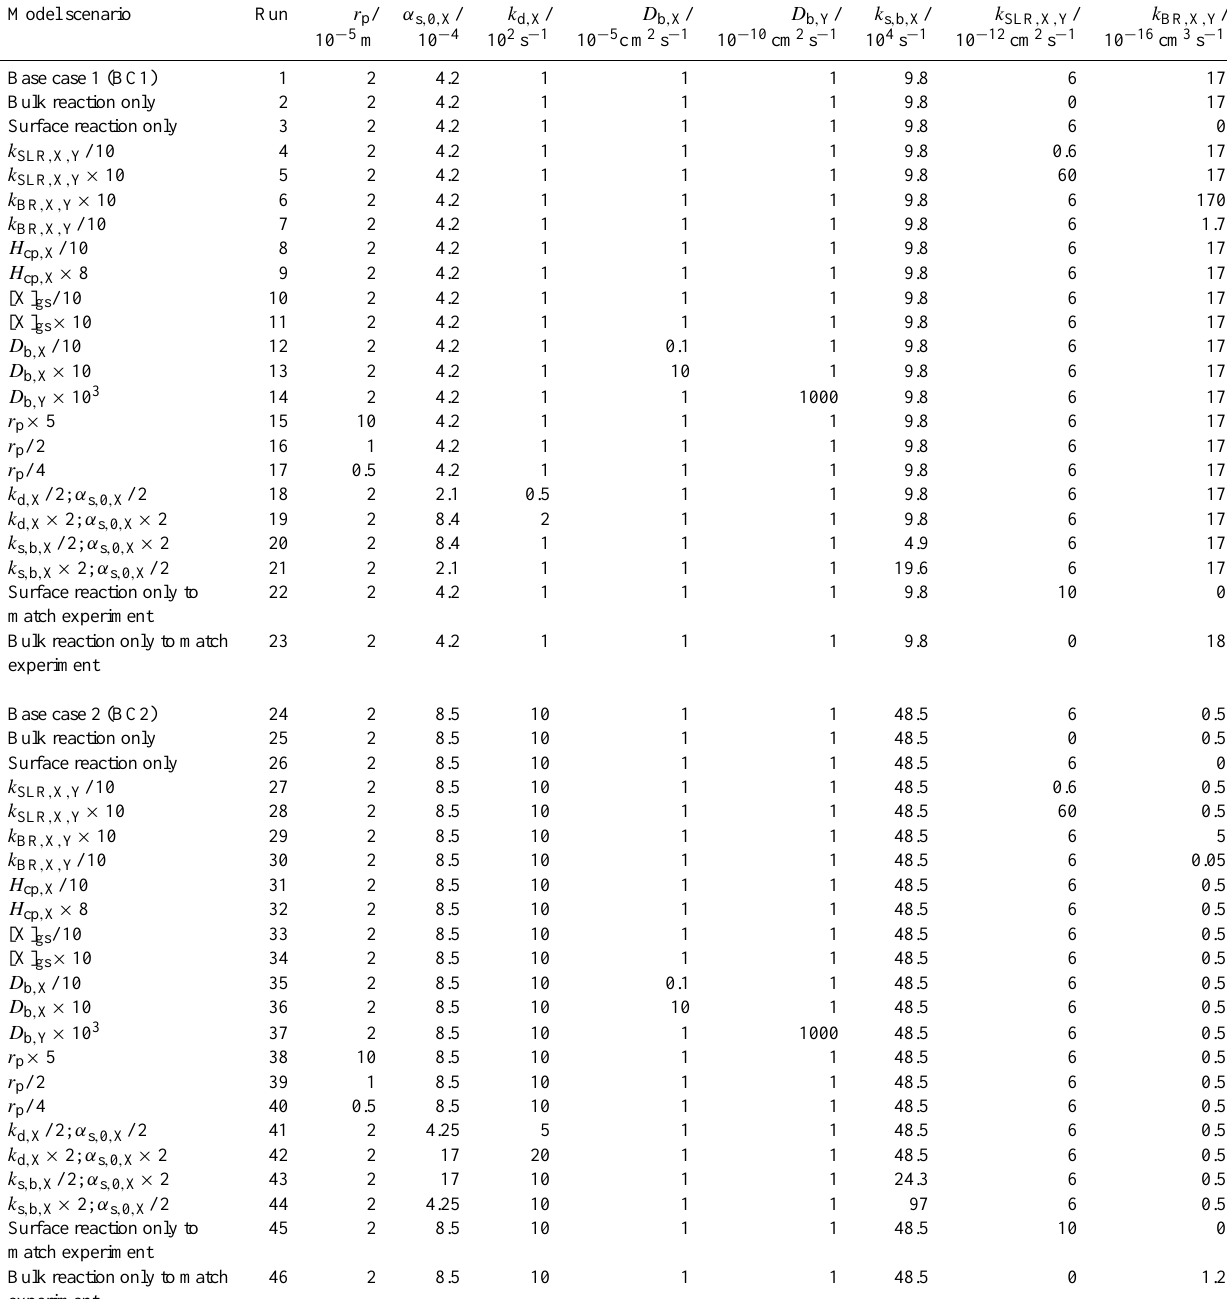
Table 2. Physico-chemical parameters investigated in the model simulations (base cases and sensitivity studies; the complete set of data is presented in the electronic supplement, see http://www.atmos-chem-phys.net/10/4537/2010/acp-10-4537-2010-supplement.zip). Model